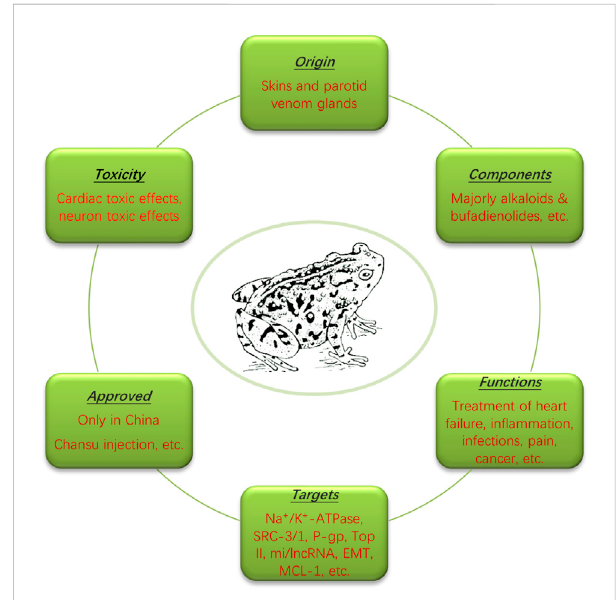
The origin, components, functions, toxicity and mechanisms of toad venom. Originated from the skin and auricular glands of Chinese toad, toad venom contains mostly alkaloids and bufadienolides, functioning to treat heart disease, in fl ammation, infection, pain and cancer through regulating Na + /K + -ATPase, SRC-3 and -1, etc. Drugs containing toad venom are only approved in